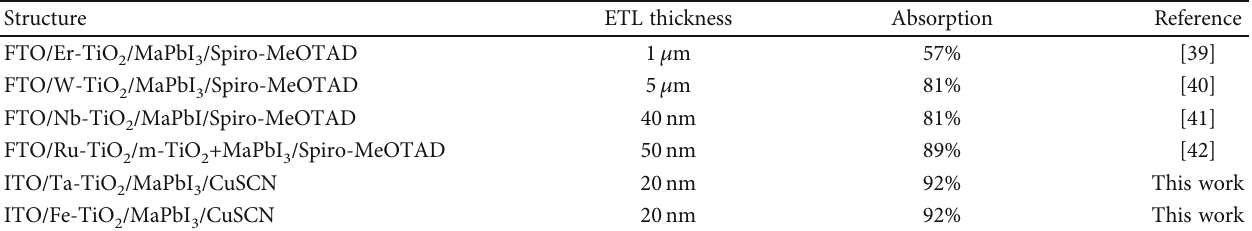
as ETL layers. 2 dopant. 2